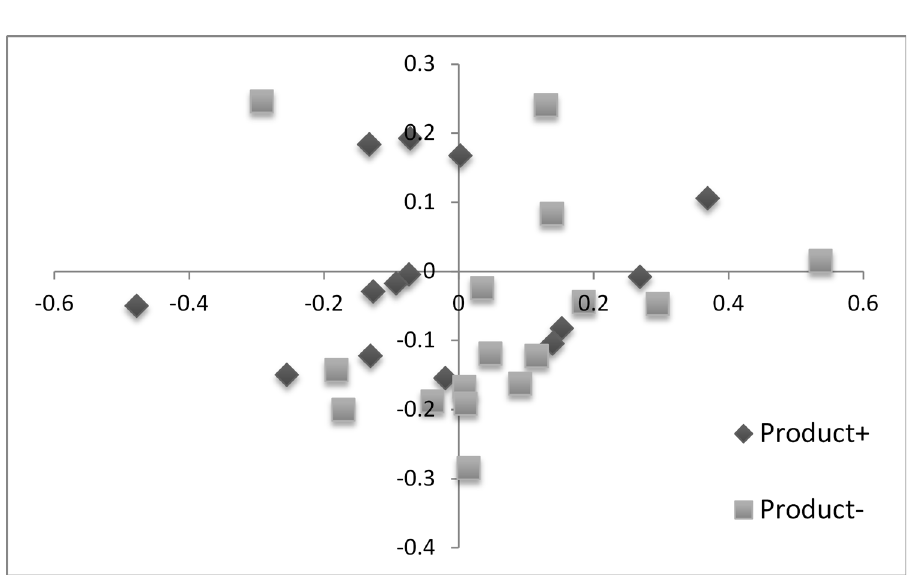
Fig 4. NMDS plot illustrating the chicken microbiome beta-diversity according to feed additive use. Each point represents a single chicken caecal microbiome; based on a subsample of 898 OTU.